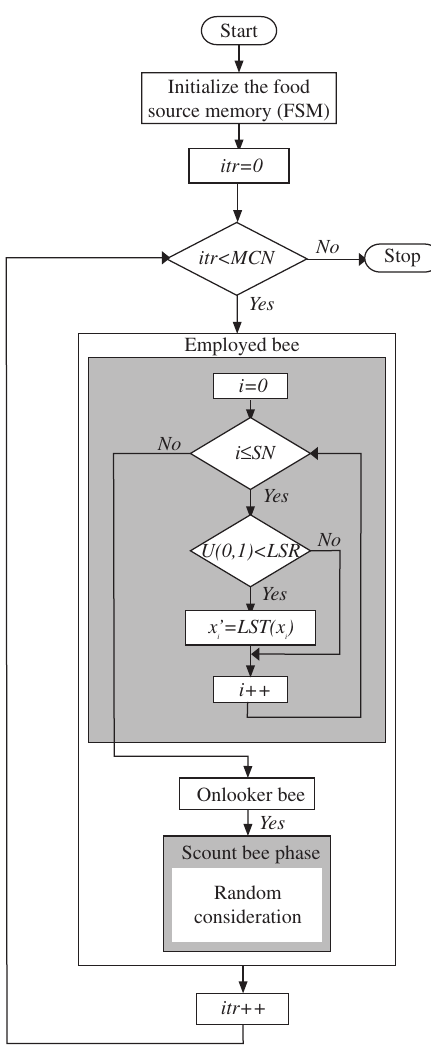
Figure 4. Flowchart of the HABC